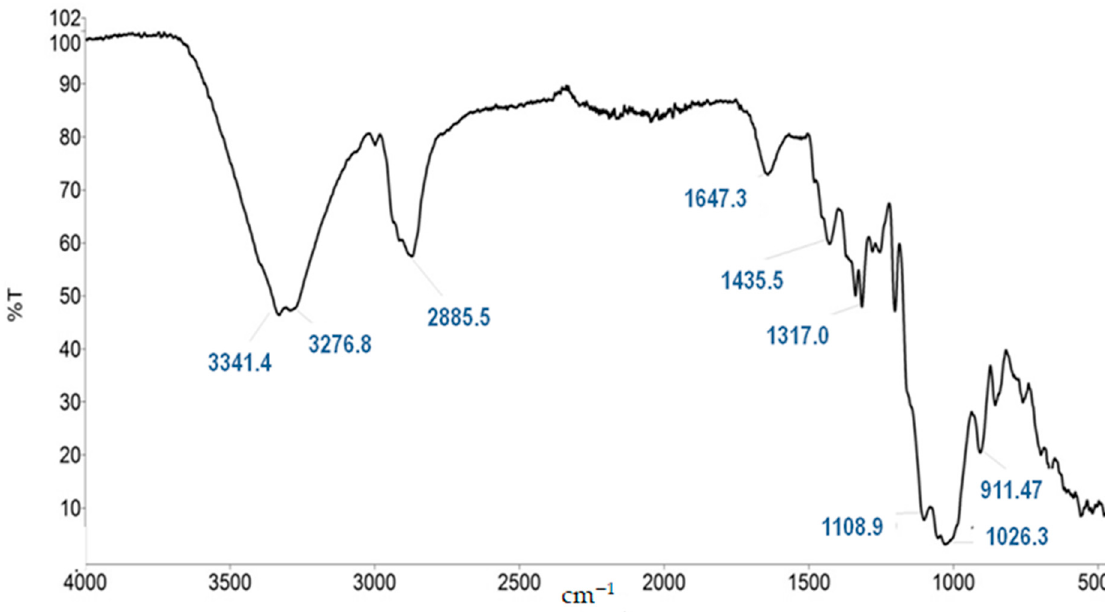
Figure 4. FTIR spectra of the textile material before functionalization with microcapsules.